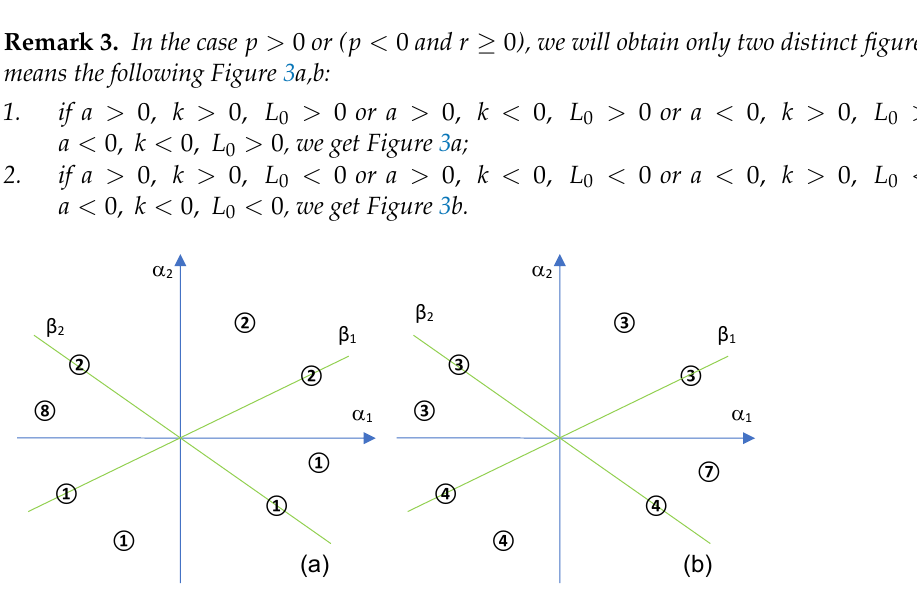
Figure 3. Bifurcation diagrams when p > 0 or ( p < 0 and r > 0) and hk > 0: ( a ) a > 0, k > 0, L 0 >